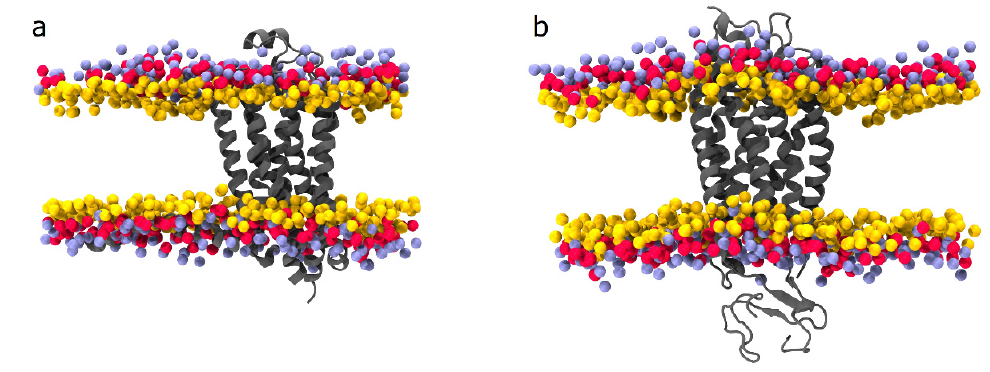
(Figure 3b), thromboxane receptor (TXA2) (PDB ID: 6IIU) [244] (Figure 3c), and protein kinase C (PDB ID: 2I0E and 1A25) [245,246].